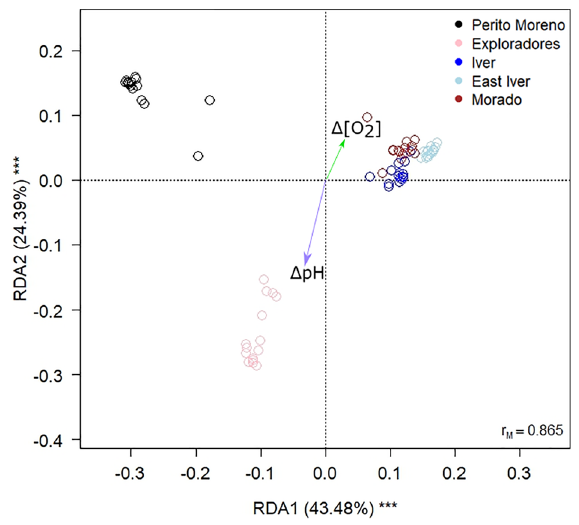
Figure 4. Correlation biplot from RDA on Hellinger-transformed bacterial ASVs abundances of all the samples according to glacier (five-level factor), pH and oxygen concentration centred to their mean value per glacier. The green arrow indicates increasing values of oxygen concentration in each glacier, while the violet one increasing pH values in each glacier. The percentage of variance explained by each axis and their significance (***:P < 0.001) is reported. r M is the Mantel correlation coefficient between the Hellinger distances between samples and the Euclidean distances between the corresponding symbols in the graph. Values close to one indicate that the graph correctly represents the distance between